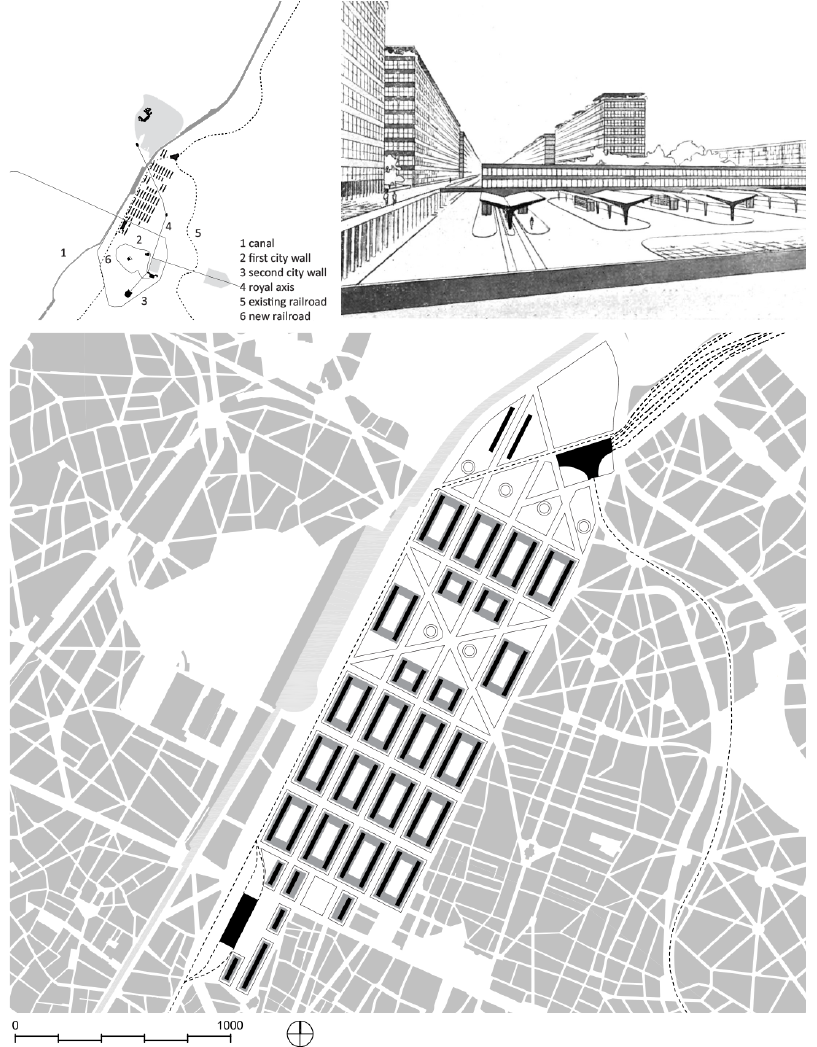
Figure 1. Bourgeois, Le Grand Bruxelles , 1929 (drawings by the author; perspective drawing by Bourgeois, 1930, p. 175). CIAM peers advocated substituting “the existing urban pattern in favour of widely spaced high-rises” (Mumford, 2002, p. 58). Dwellings are contained in 11-storey build- ings oriented north-south and linked in pairs by double- height plinths to create genuine urban blocks.